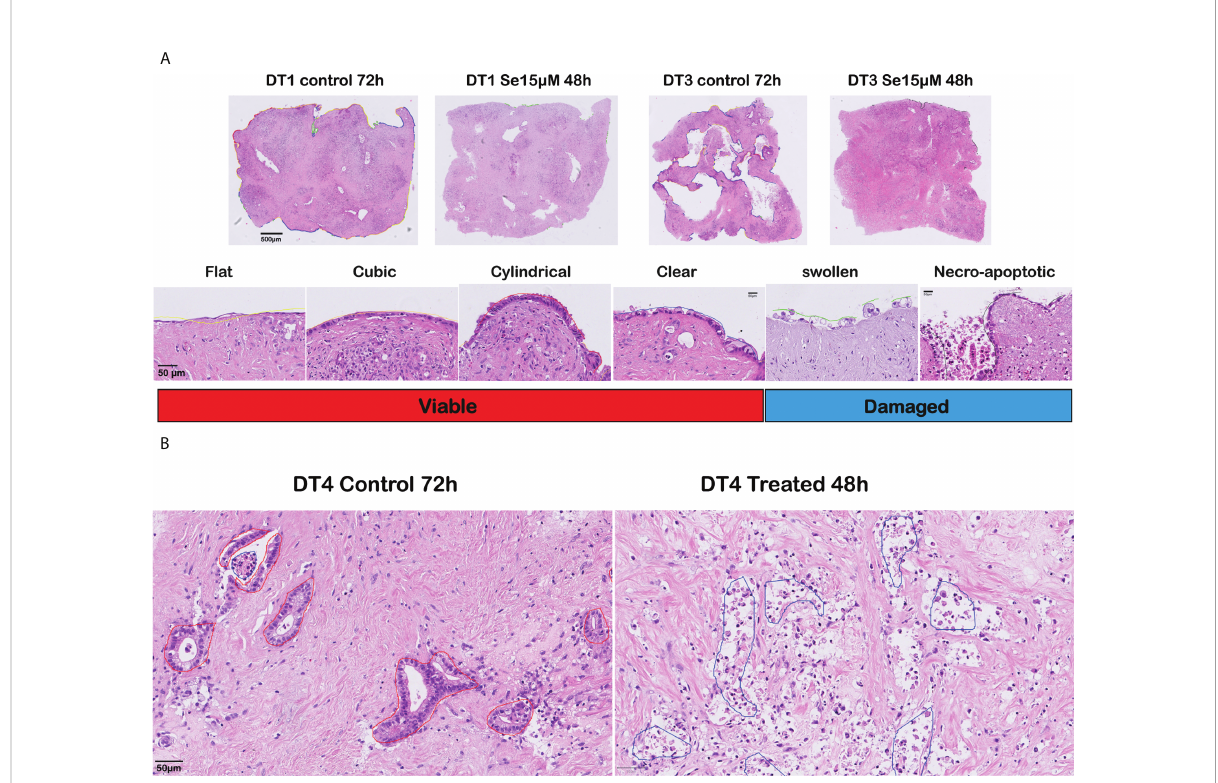
FIGURE 2 Histomorphological assessment of responses to sodium selenite treatments and reduction of cancer cell viability in ex vivo cultured tissue slices of human PDAC. (A) (Top) Overview of cultured tissue slices with cell outgrowth annotations as lines in different colors corresponding to the various outgrowth types (scale bar 500 m m). (Bottom) Representative examples (H&E-staining) of the different outgrowth types and grouping for analysis ( “ Viable ” , “ Damaged ” ) (scale bar 50 m m). (B) Representative photomicrographs of a moderately differentiated PDAC in untreated (left) and treated (right) tissue slices (scale bar 50 m